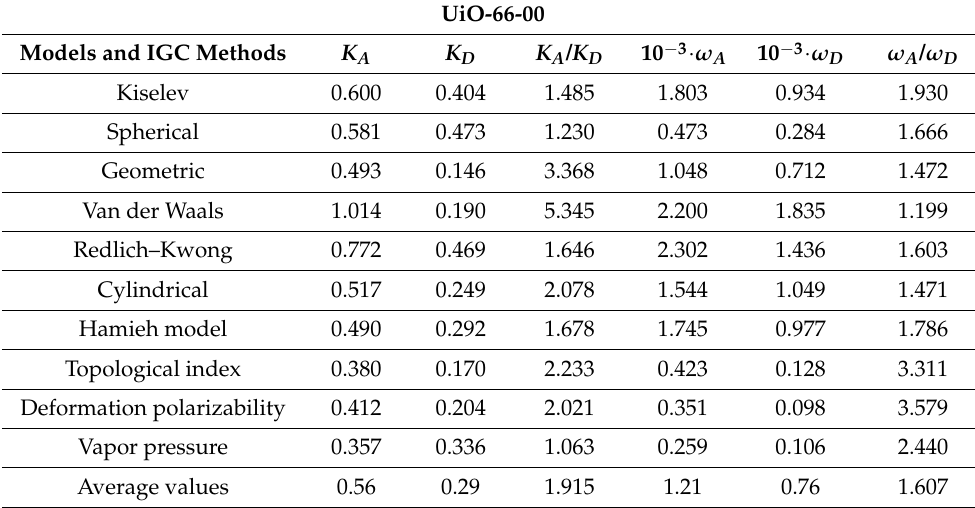
Table 6. Values of the enthalpic acid–base constants K A and K D (unitless) and the entropic acid– base constants ω A and ω D (unitless) of UiO-66-00 and their acid–base ratios for the different used molecular models and IGC methods.